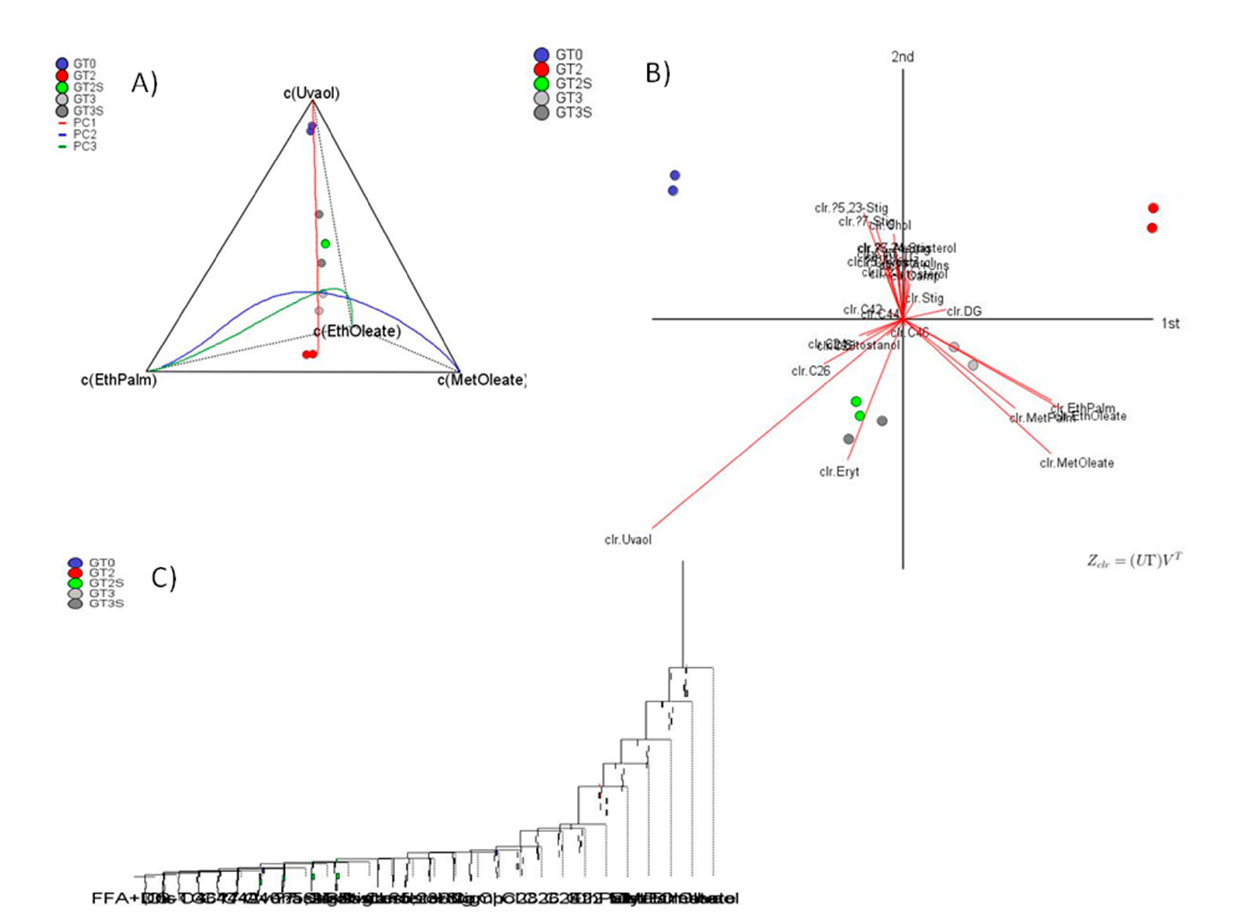
Figure 2. Changes in the minor components of the green Spanish-style Gordal table olive fat, according to processing phases and extraction methods, using specific exploratory tools for compositional data analysis: ( A ) tetrahedral plot in the simplex as a function of compounds with the highest logratio variability, ( B ) form biplot and ( C ) balance dendrogram. GT0, GT2 and GT3 are oils extracted from the fresh, fermented and packaged olives, respectively. Samples coded S were extracted by Soxhlet; otherwise, they were extracted by Abencor. See Table 1 for other abbreviations.